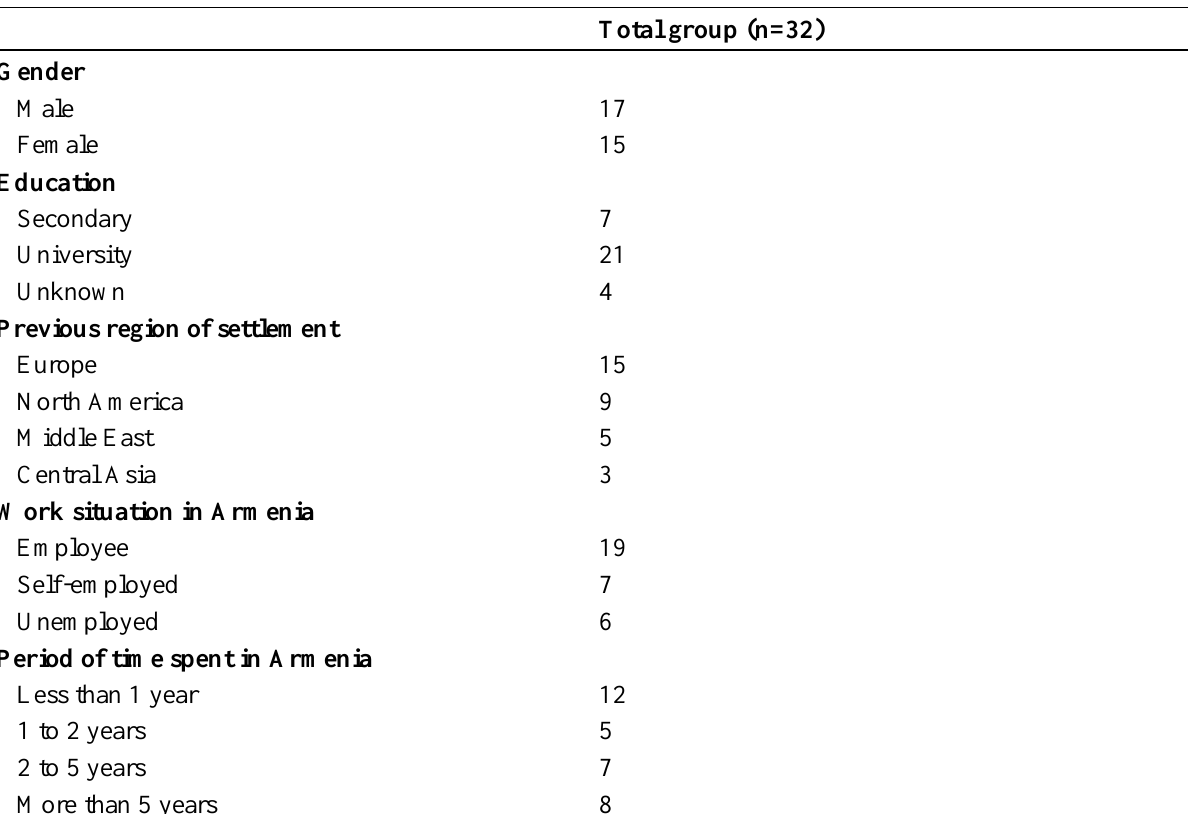
Table 1. Overview of the interviewed